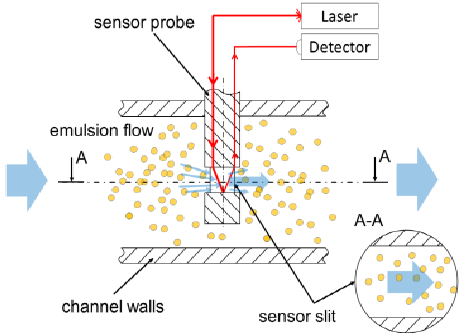
Figure 1. Measurement arrangement of inline light transmission sensor probe with cylindrical shaft in a flow channel of machining process.